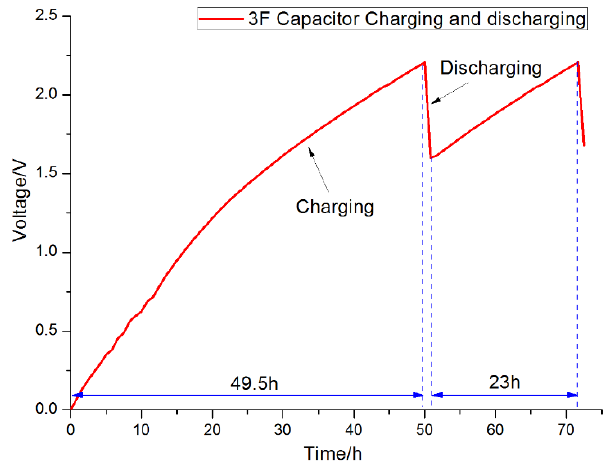
Figure 12. Charging and discharging curves of the 3 F